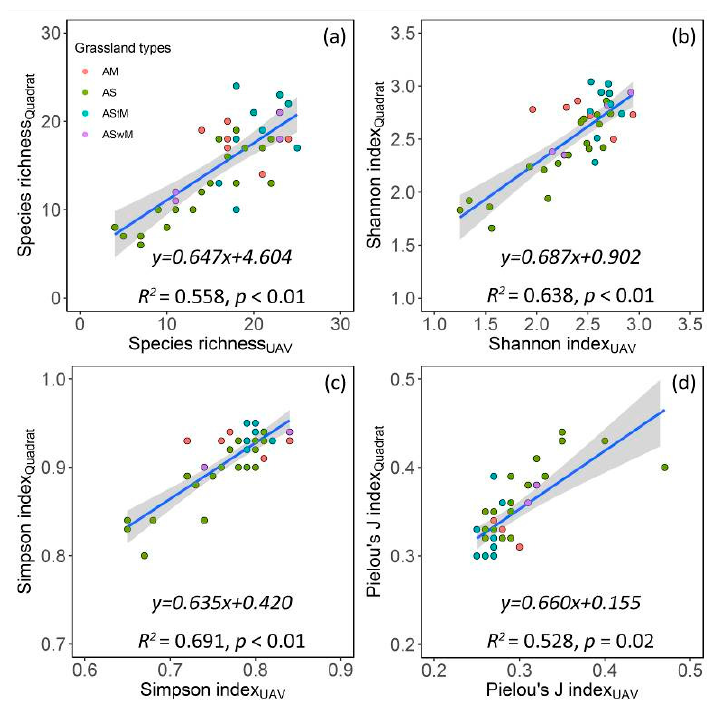
Figure 4. Relationships of diversity indexes (( a ) species richness, ( b ) Shannon index, ( c ) Simpson index and ( d ) Pielou’s J index) between the Quadrat method and UAV method. The shaded area shows the 95% confidence interval of the fit. ASwM, AM, AStM and AS indicate alpine swamp meadow, alpine meadow, alpine steppe meadow and alpine steppe, respectively.